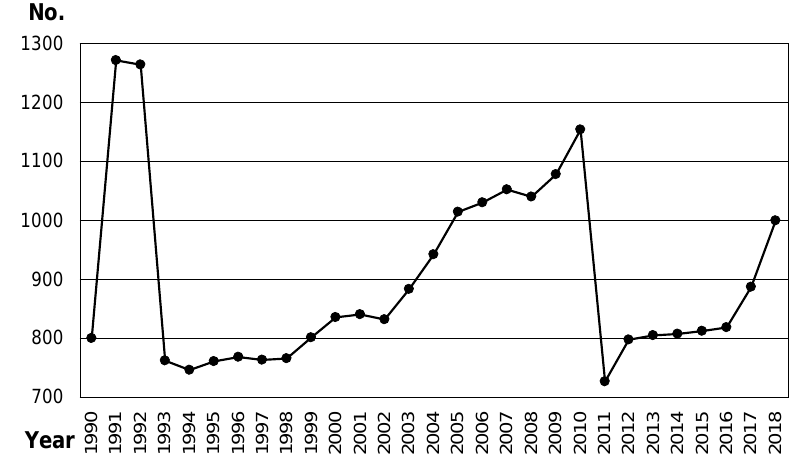
Figure 9. Dynamic of the number of tourism facilities on the Romanian seaside during 1990–2018. Source of data: Romanian Statistical Yearbooks (National Institute for Statistics).